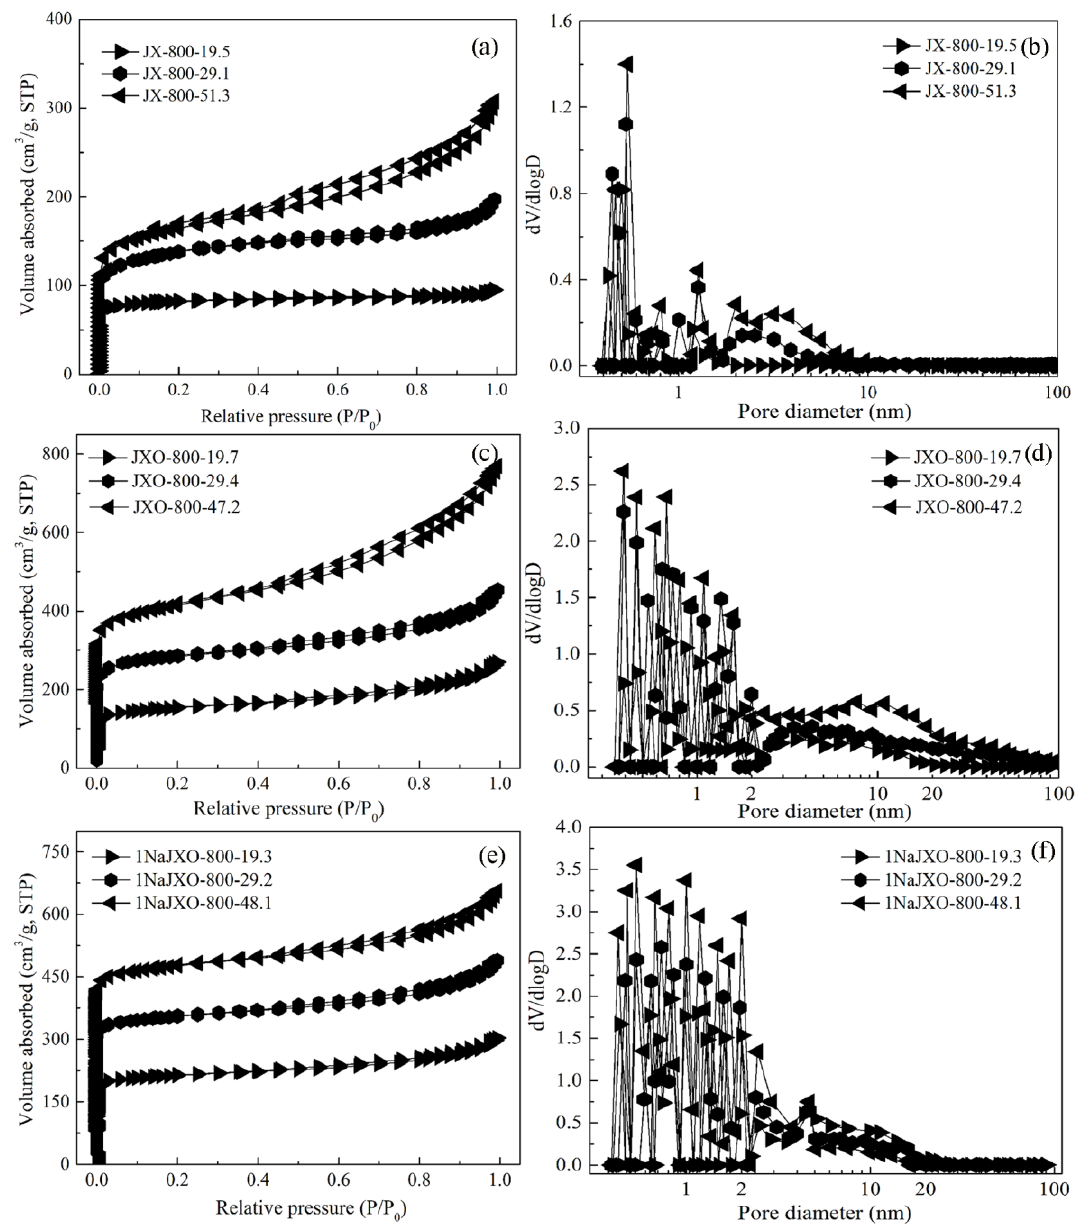
Figure 4. N 2 adsorption isotherms ( a ), ( c ) ( e ) and pore-size distributions ( b ), ( d ) ( f ) of activated carbons at different burn offs. Table 5. Pore structure parameters of typical chars at different burn offs.